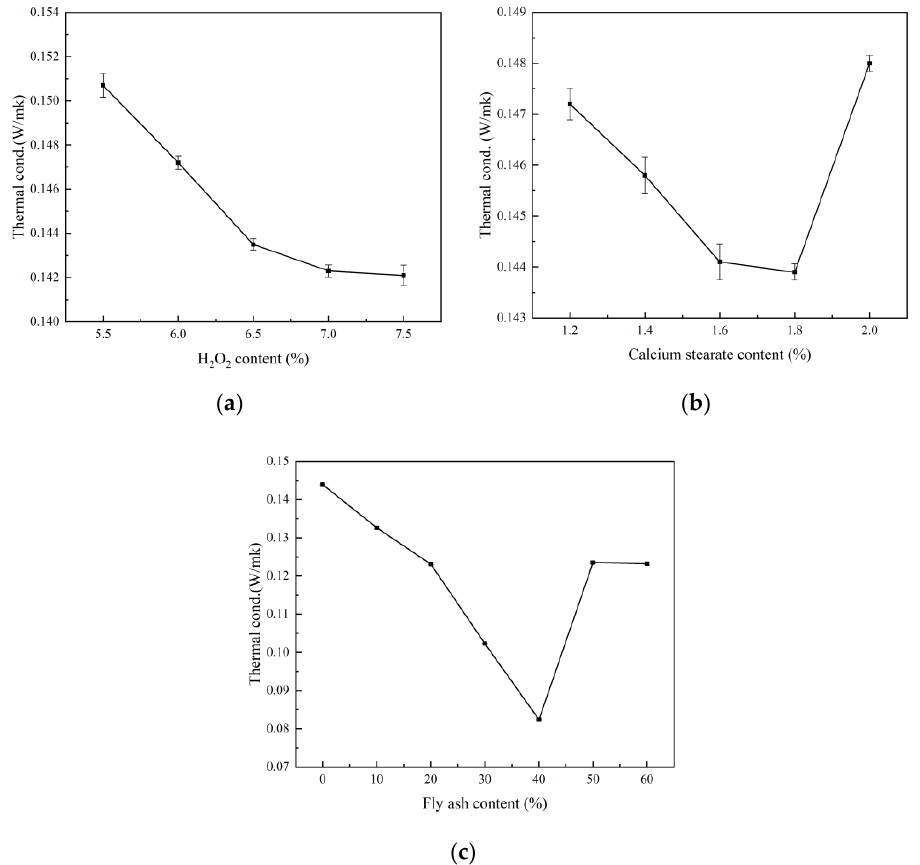
Figure 5. Compressive strength of foam concrete: ( a ) H 2 O 2 content; ( b ) calcium stearate content; ( c ) fly ash content.